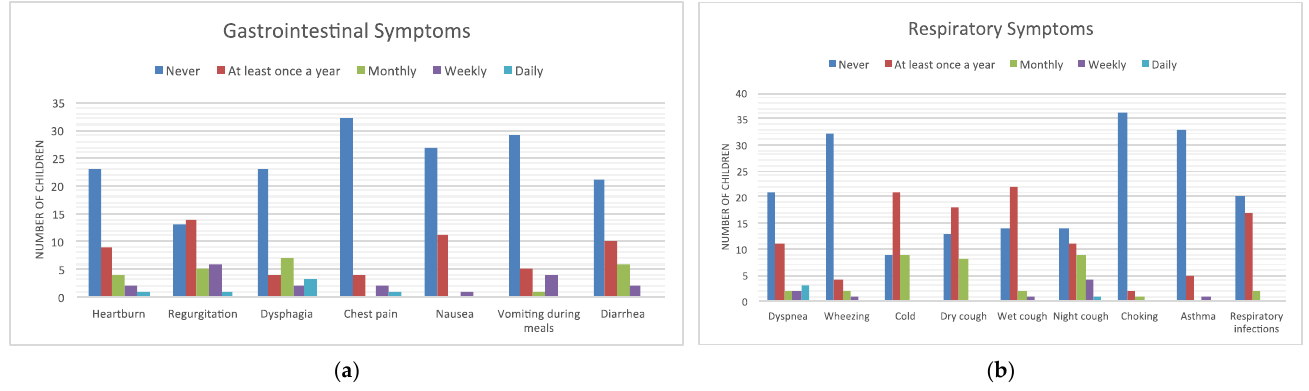
Figure 1. Prevalence and frequency of gastrointestinal ( a ) and respiratory symptoms ( b ).